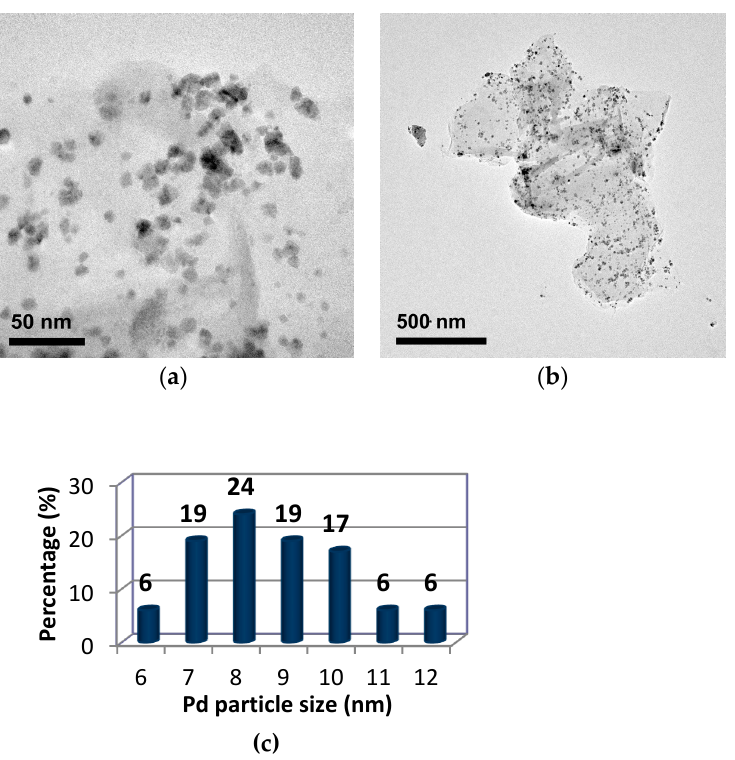
Figure 3. TEM pictures ( a , b ) and Pd NPs size distribution ( c ) for Pd/GO-B.